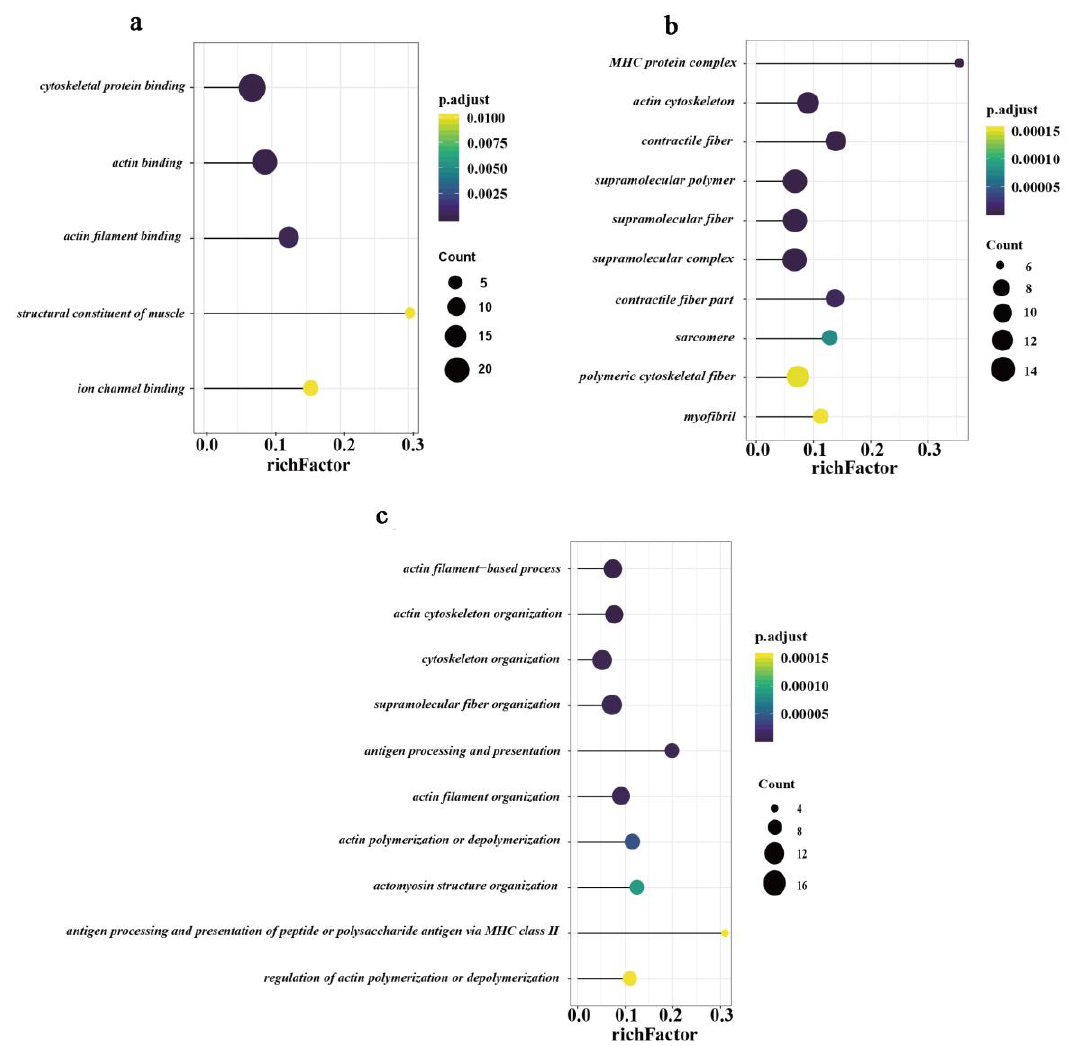
Figure 4. GO (gene ontology) enrichment annotation of all differentially expressed proteins. ( a ) All five GO terms for molecular function. ( b ) Top ten GO terms for the cellular component. ( c ) Top ten GO terms for biological process. The X-axis indicates a rich factor, and the Y-axis indicates terms. Colors of dots represent p -values, and sizes of dots represent the number of genes.